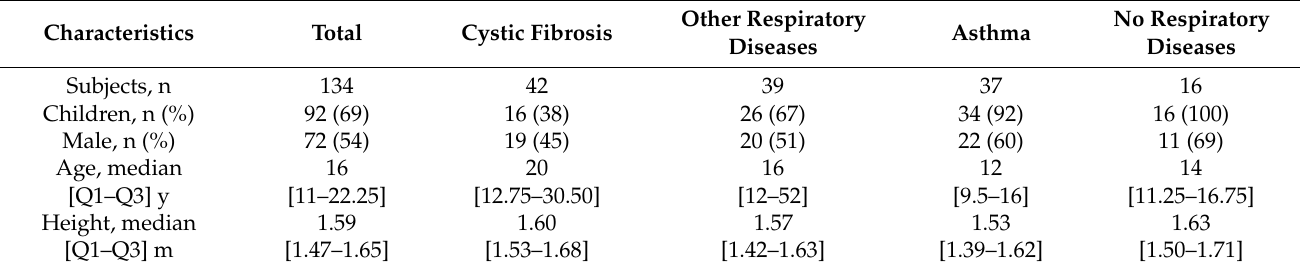
Figure 3. Flowchart with the number of recordings and participants throughout the study. Table 1. Participants’ characteristics (n = 134).